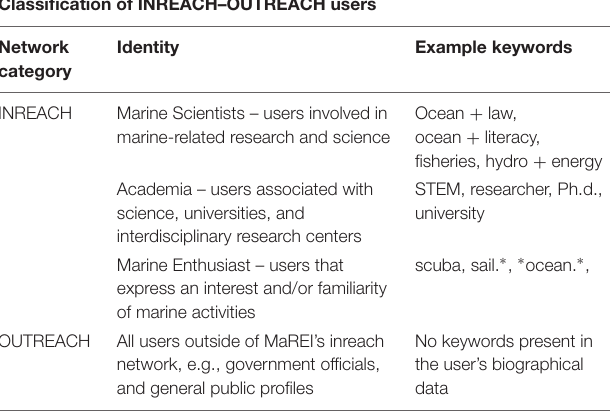
TABLE 1 | Categorization of MaREI’s INREACH–OUTREACH groups using regular expression